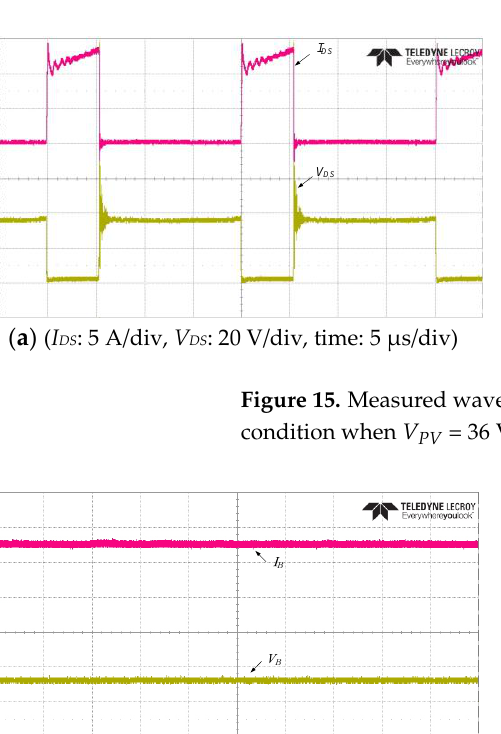
condition when V PV = 36 V: ( a ) switch M 2 and ( b ) switch M 3.